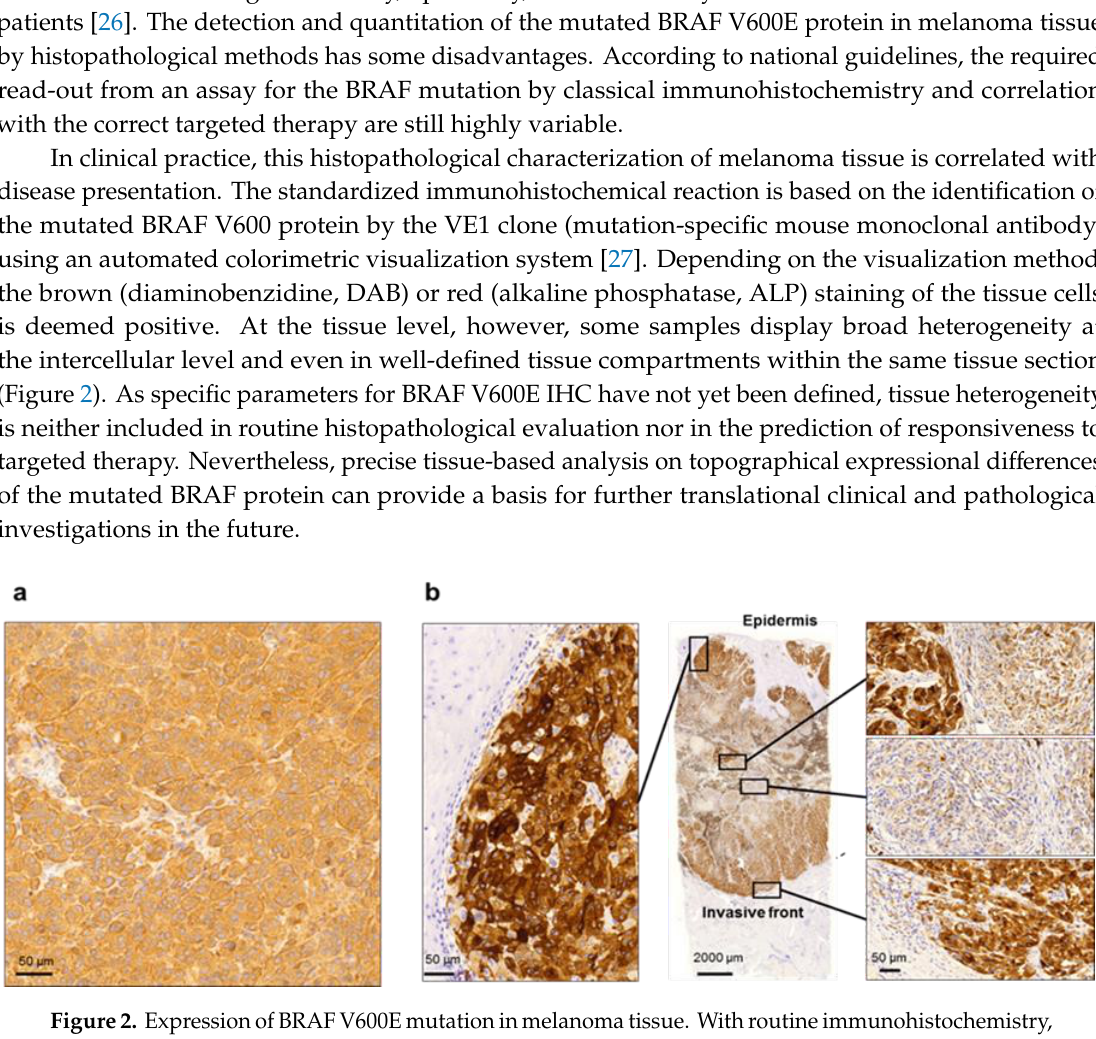
Figure 2. Expression of BRAF V600E mutation in melanoma tissue. With routine immunohistochemistry, the distribution of BRAF V600E mutation can be easily detected in melanoma tissue by a standardized colorimetric assay. Mutated BRAF V600E proteins react with HRP-DAB (peroxidase conversion of diaminobenzidine) ( a ) Homogeneity of the BRAF V600E protein expression. ( b ) Heterogeneity of the BRAF V600E protein expression. The peripheral and focal central regions of show a pronounced expression of the mutated protein. In areas with mild V600E expression, there is marked intercellular heterogeneity. BRAF V600E IHC, clone VE1, HIER (heat-induced epitope retrieval) pH = 9; OM 112 ×.